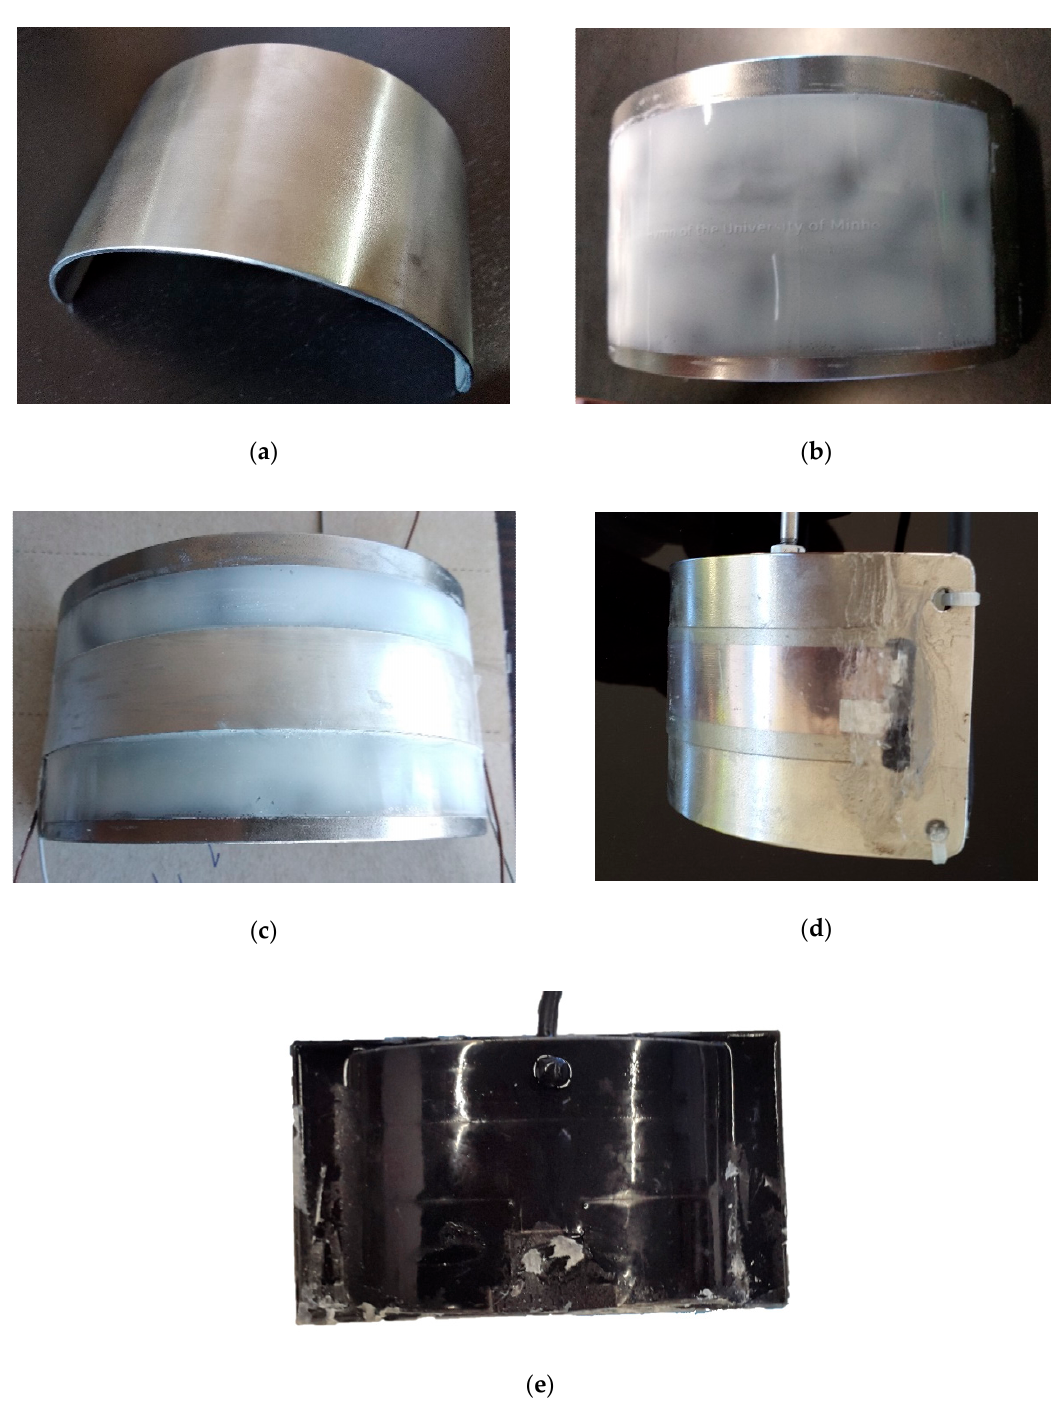
Figure 4. Photographic history of the transducer manufacturing: ( a ) curved stainless-steel sheet backing layer; ( b ) isolator layer, ( c ) polymer ultrasound transducer (PVDF) film; ( d ) waterproofing silicone layer and ( e ) final coat of black Polyurethane resin.